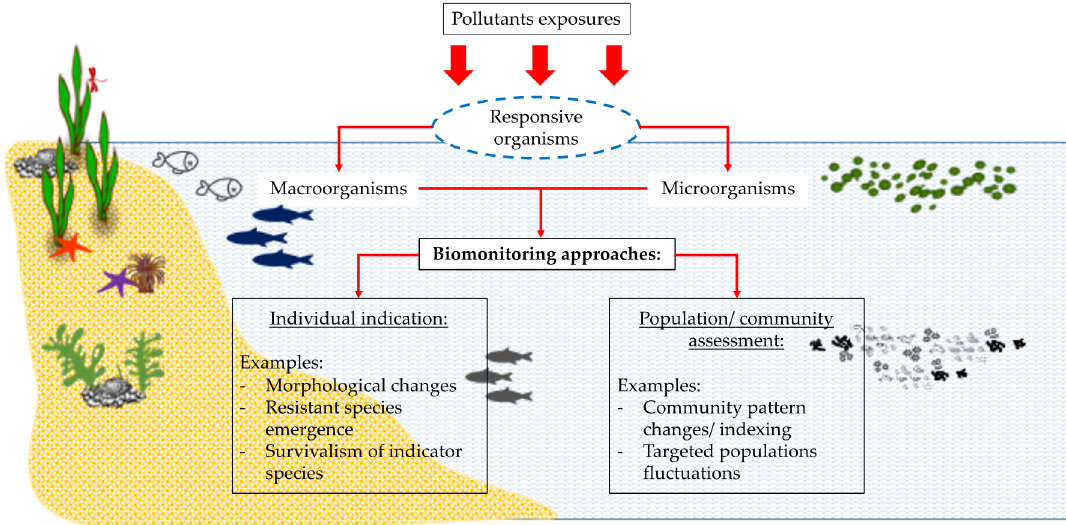
Figure 3. Biomonitoring aquatic pollution by utilizing either indigenous macroorganisms or microorganisms which are a ff ected by the presence of